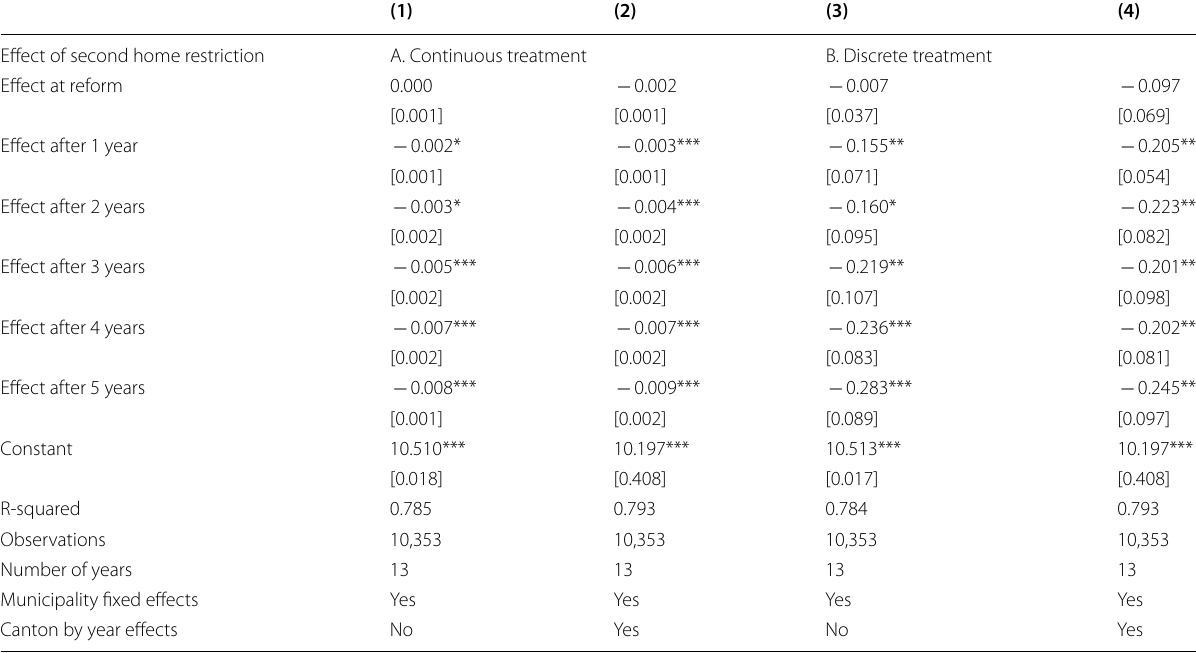
Table 2 Results of the event study of the effect of the second home restriction (with continuous and discrete treatment variable) on new construction investments (in natural